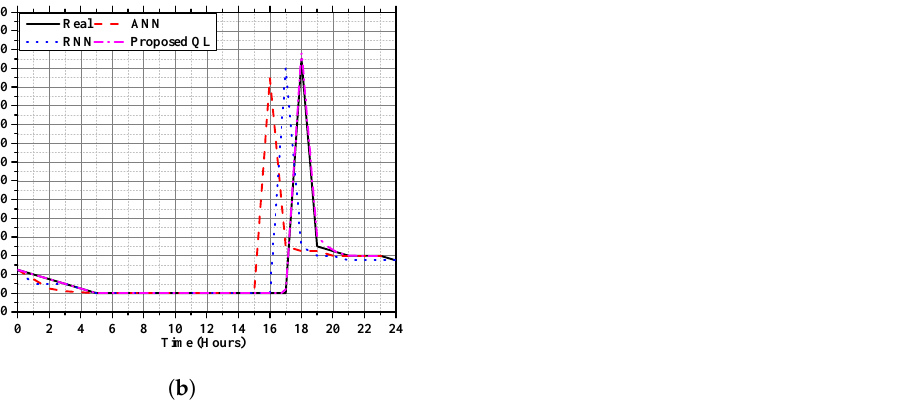
Figure 7. Non-cooperative charging PHEV load forecasting with a 30% and 60% penetrations. ( a ) Non-cooperative charging PHEV load forecasting with a 30% penetration. ( b ) Non-cooperative charging PHEV load forecasting with a 60% penetration.